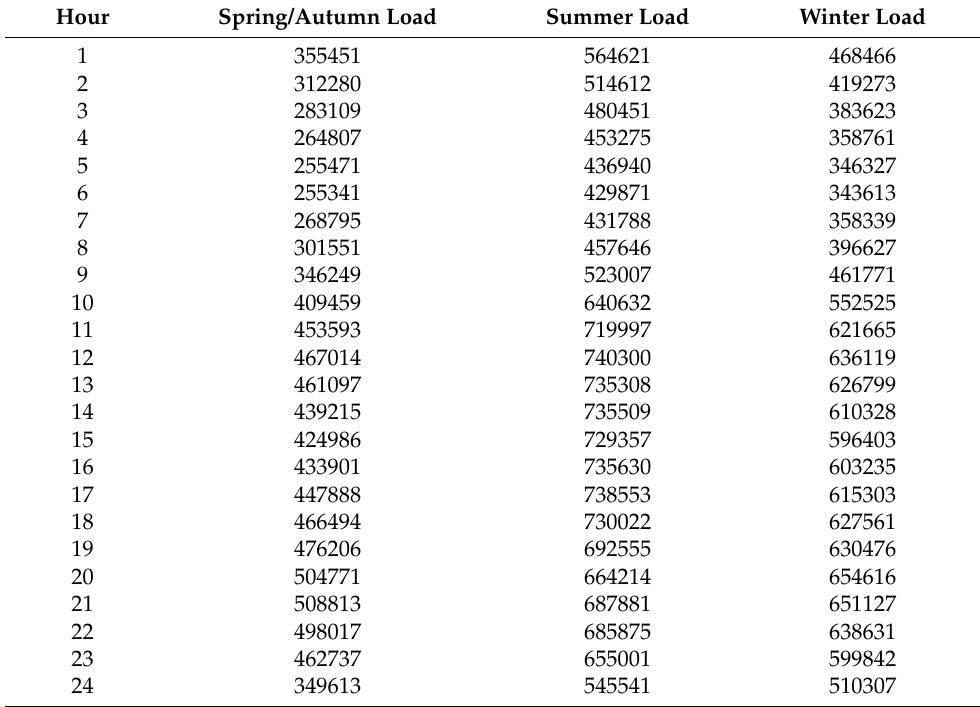
Table A4. Typical load of a province in four